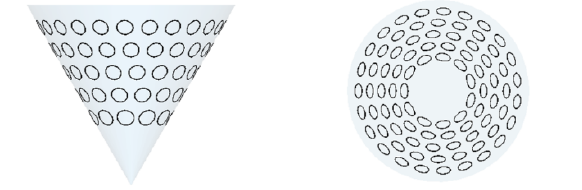
Fig. 14. Structure made of circular loop wires conformed on a cone: side (left panel) and top (right panel) views